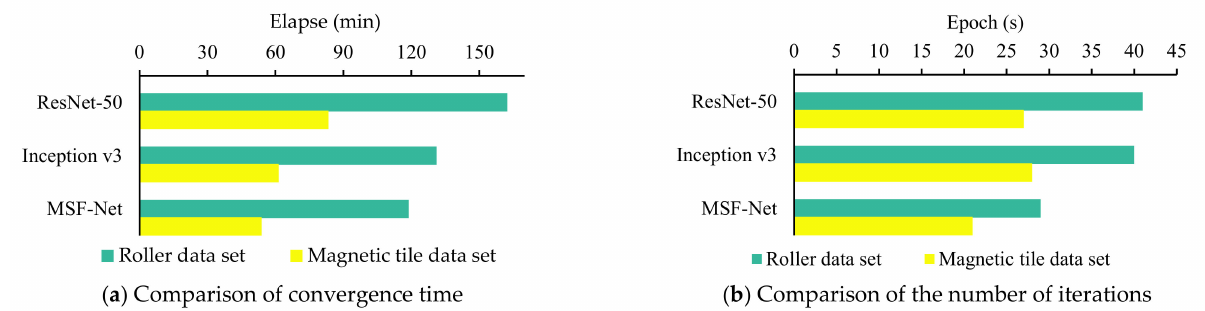
Figure 13. Comparison of the time and the number of epochs required for three CNNs to reach